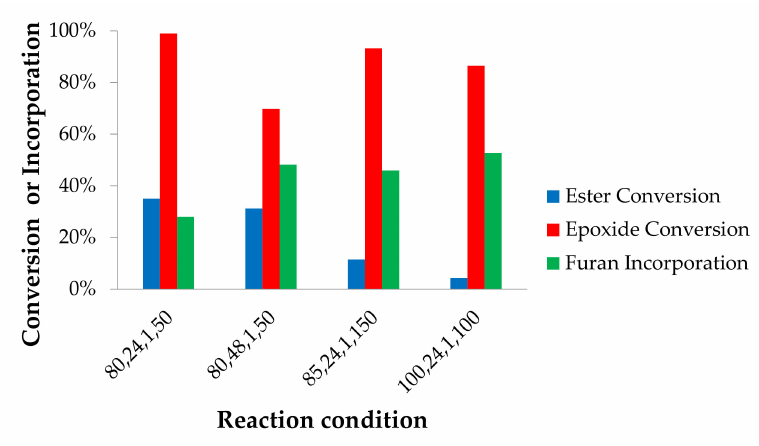
Figure 7. Ester and epoxide conversion and furan attachment in the presence of LiBr at various reaction conditions. The x-axis represents reaction temperature ( ◦ C), time (h), molar ratio of furfurylamine to the epoxides, and LiBr loading (% of epoxidized oil).